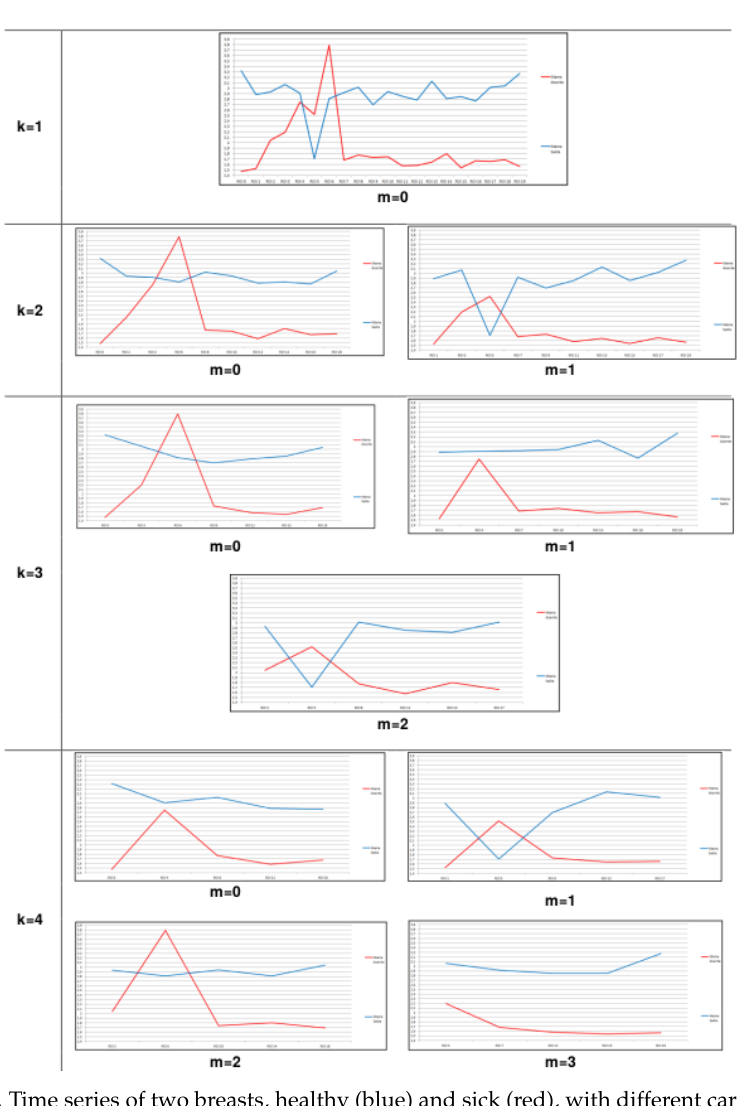
Figure 10. Time series of two breasts, healthy (blue) and sick (red), with different cardinalities.